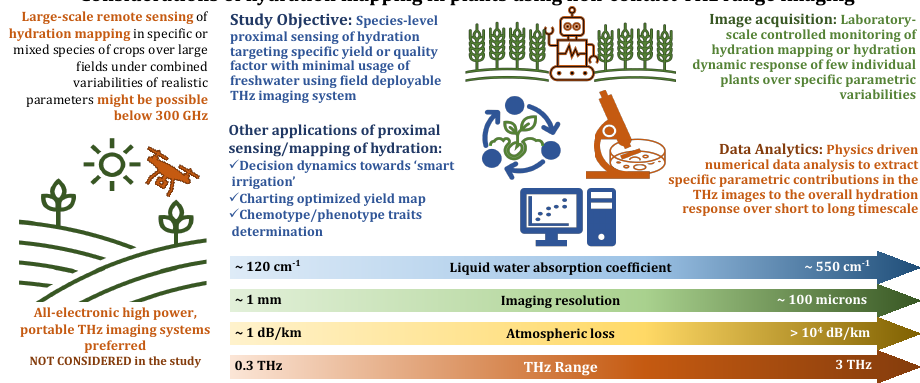
Figure 1. Approaches toward THz hydration mapping in